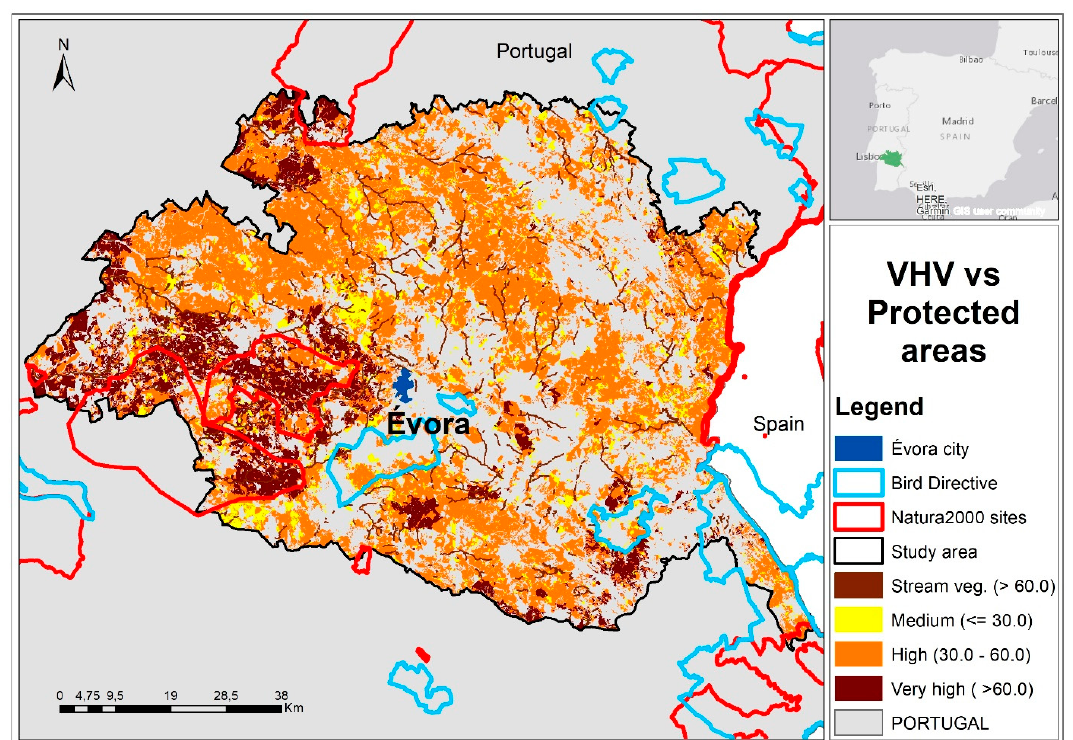
Figure 6. Interception of VHV map with the Protected Areas (Nature 2000 sites and Bird Directive sites) (author: T. Batista).